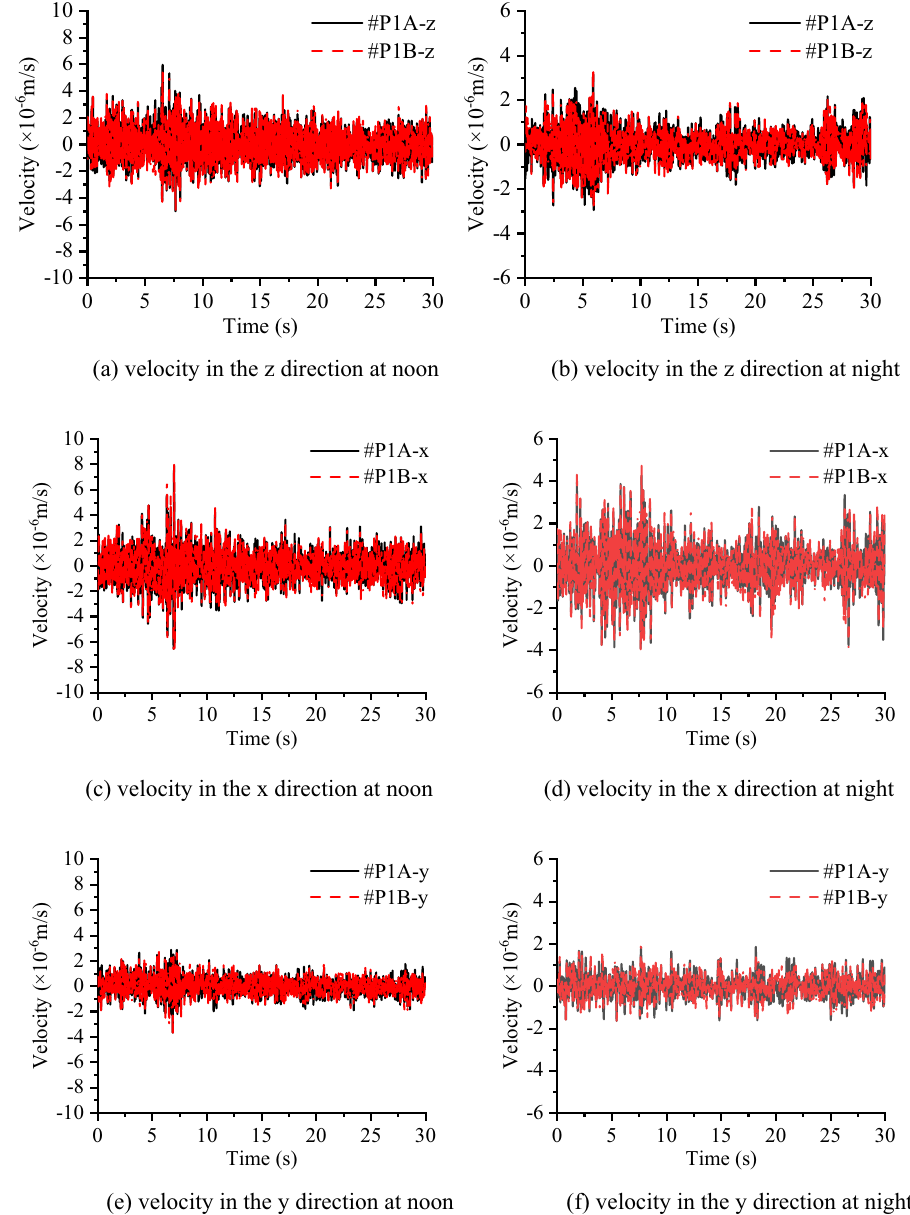
Figure 10. Comparison of the measured velocities at heights of 0.4 m and 2.2 m on the concrete layer in group